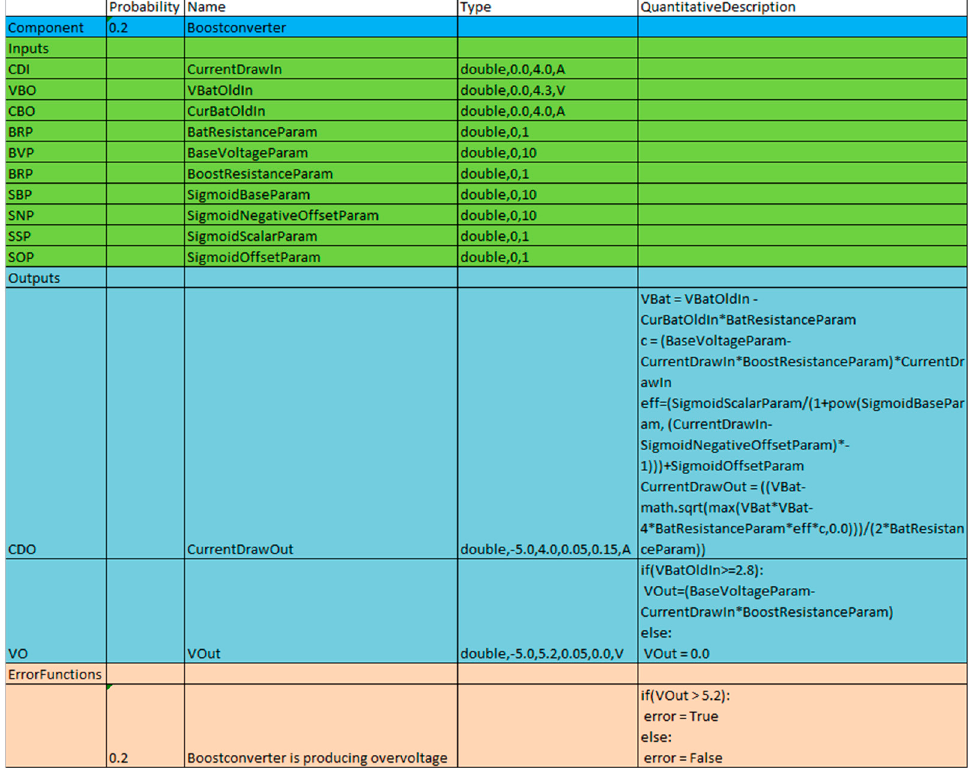
Figure 4. Example component class of a boost converter. The name of the component class and its a priori failure probability are defined in the dark blue block, the input ports are defined in the green block, the output ports are defined in the blue block and the error functions are defined in the light red block.